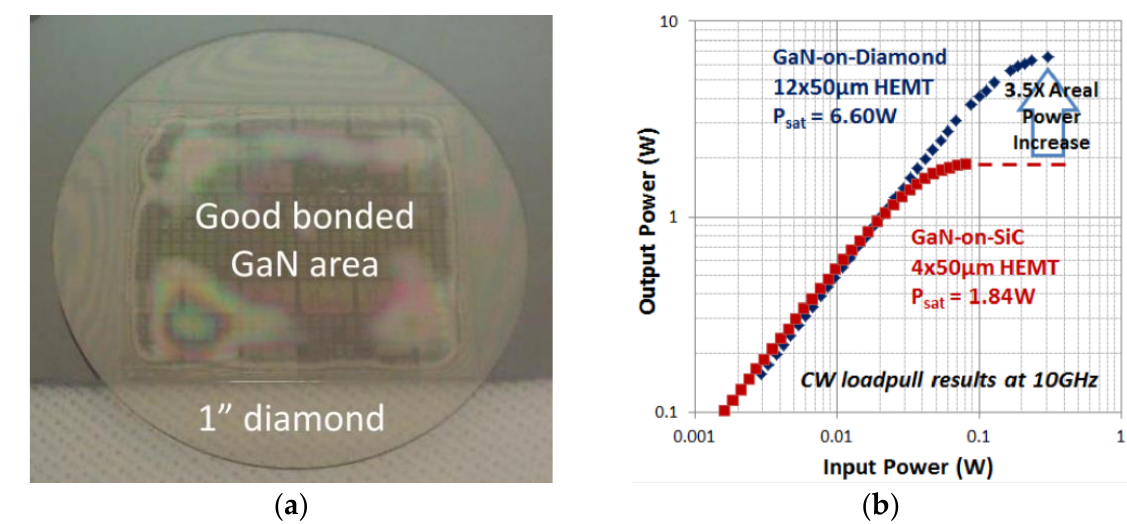
Figure 7. ( a ) GaN HEMTs bonded to a 1 ″ PCD substrate (© 2014 IEEE. Reprinted, with permission, from K. K. Chu et al., “S2 -T4: Low-temperature substrate bonding technology for high power GaN- on-diamond ” , Lester Eastman Conf. 2014 - High Perform. Devices, LEC 2014, pp. 1 – 4, 2014 [109]). ( b ) Comparison of input-output power curves obtained at 10 GHz for GaN/diamond HEMT with 3 times larger gate periphery than GaN-on-SiC HEMT (© 2015 IEEE. Reprinted, with permission, from K. K. Chu et al., “High -Performance GaN-on-Diamond HEMTs Fabricated by Low-Temperature Device Transfer Process,” 2015 IEEE Compd. Semicond. Integr. Circuit Symp. CSICS 2015, pp. 7– 10, 2015 [111]).